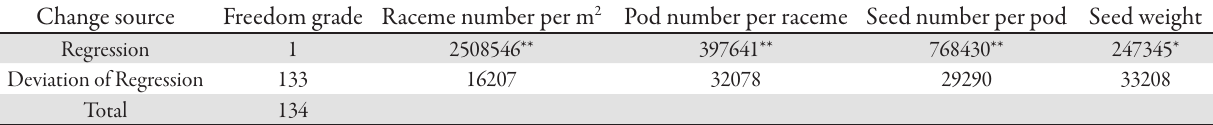
Tab. 6. Regression variance analysis of Alfalfa seed yield of ‘Mesasirsa’ Change